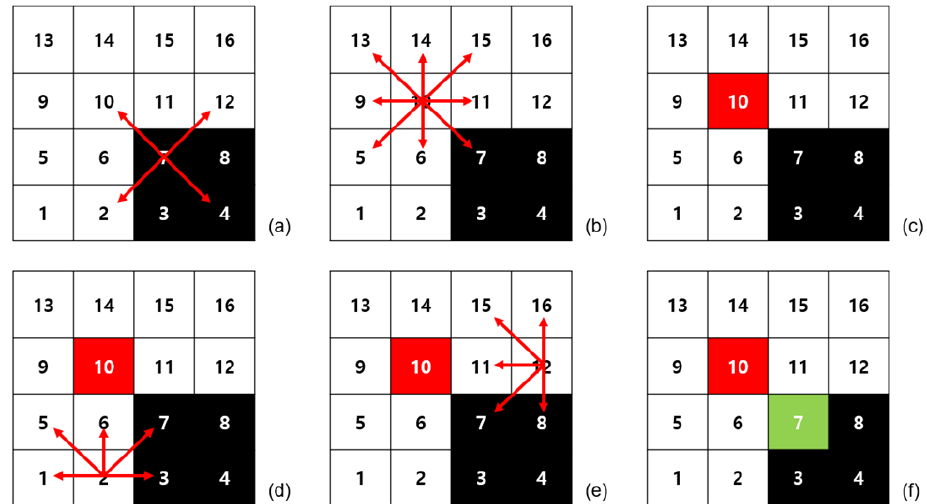
Figure 4. Node creation process. ( a ) Select one of the obstacle data lists, and then select free space data adjacent to the diagonal direction. ( b ) Select node 10 and search for adjacent data. ( c ) Create a node in the detected corner. ( d ) Select node 2 in the adjacent data, and search for the adjacent data for node 2. ( e ) Select node 12 in the adjacent data and search for adjacent data for node 12. ( f ) Corner detection is now complete for this obstacle. Algorithm 1 is pseudocode for corner detection and node generation.